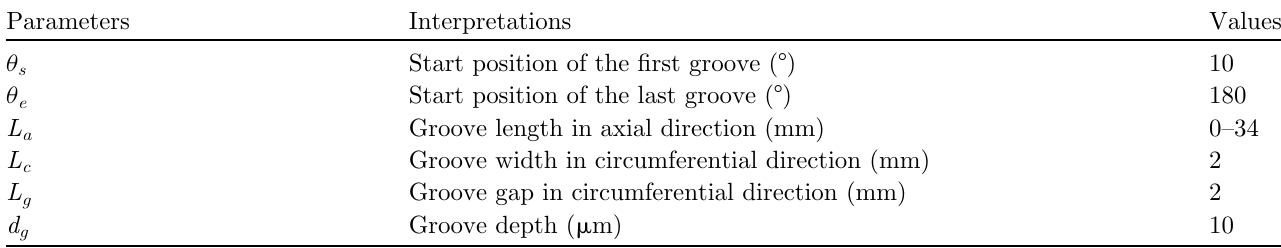
Table 2. Geometric parameters of groove